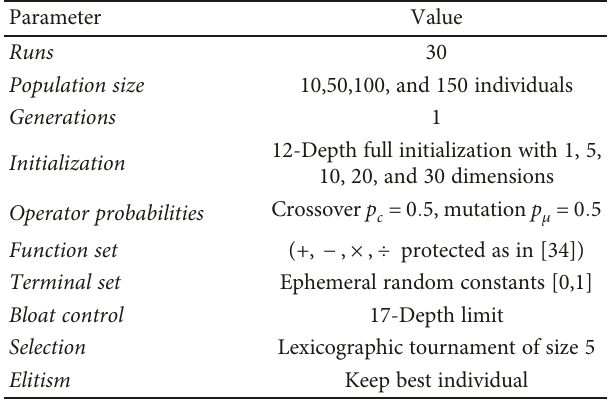
Figure 3: Parallelization options for M3GP: an example with four independent threads (or workers). After the start, a nonparallel branch and a parallel one are shown. The latter highlights possible ways to parallelize the M3GP method, that is, (i) to evolve each solution independently, (ii) to compute each branch of the fi tness tree separately, or (iii) to combine the two previous approaches. Table 3: Parameters of M3GP used in all the parallel